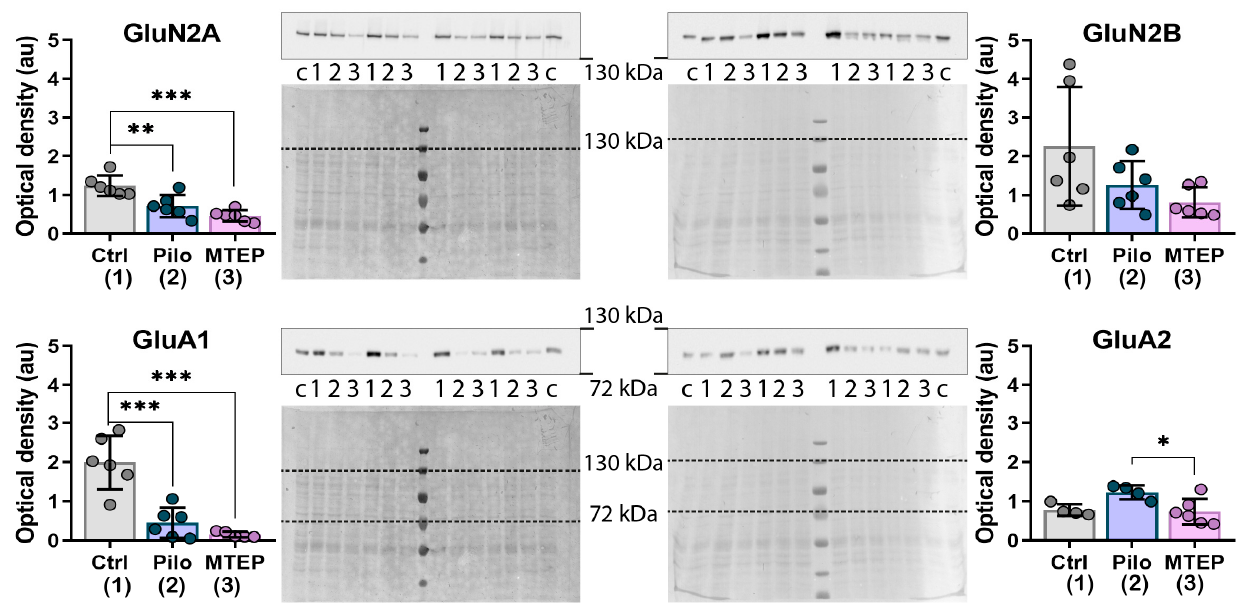
Figure 9. Western blotting data of proteins production in the dorsal hippocampus 7 days after pilocarpine-induced SE. For inserts, upper part in each line shows the chemiluminescent signal, lower part shows the Ponceau S. For bands c is calibrator sample, 1 is Ctrl, 2 is Pilo, and 3 is MTEP group. On charts each dot represents one animal; the columns indicate average values, and error bars show standard deviations. One-way ANOVA, GluN2A: F 2,17 = 16, p < 0.001; GluN2B: F 2,8 . 62 = 3.04, p = 0.10; GluA1: F 2,16 = 25.4, p < 0.001, GluA2: F 2,13 = 5.1, p < 0.05. Asterisks indicate significant differences between groups according to Tukey’s post hoc tests: * p < 0.05; ** p < 0.01, *** p < 0.001.